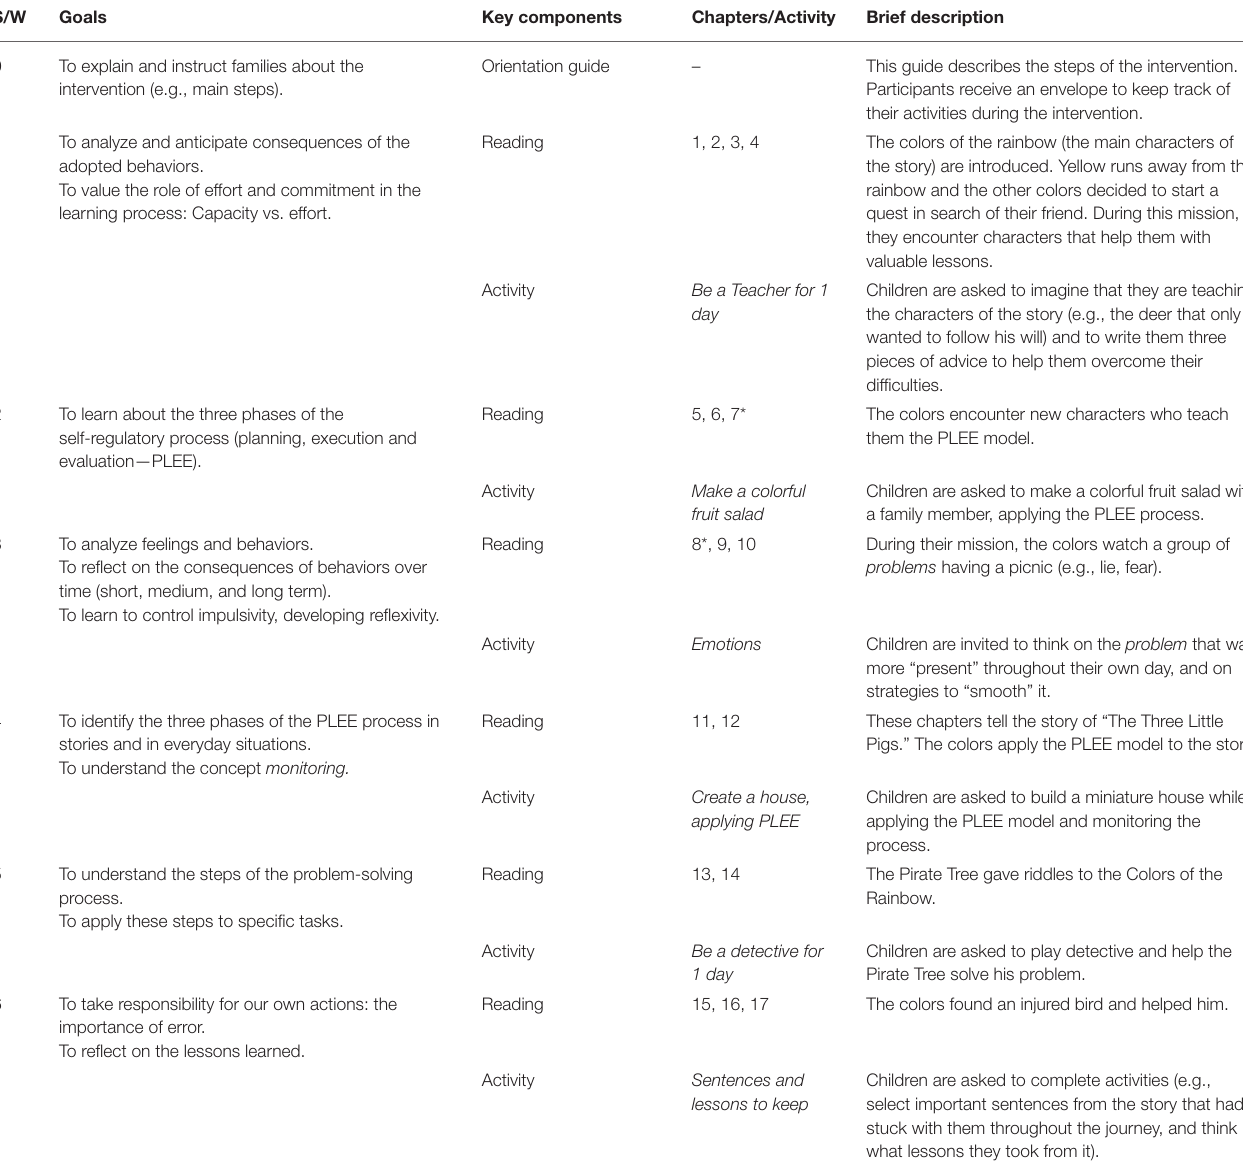
TABLE 2 | Anatomy of the adapted intervention using radio broadcasting: a week-by-week description of the goals, key components and related activities. S/W Goals Key components Chapters/Activity Brief